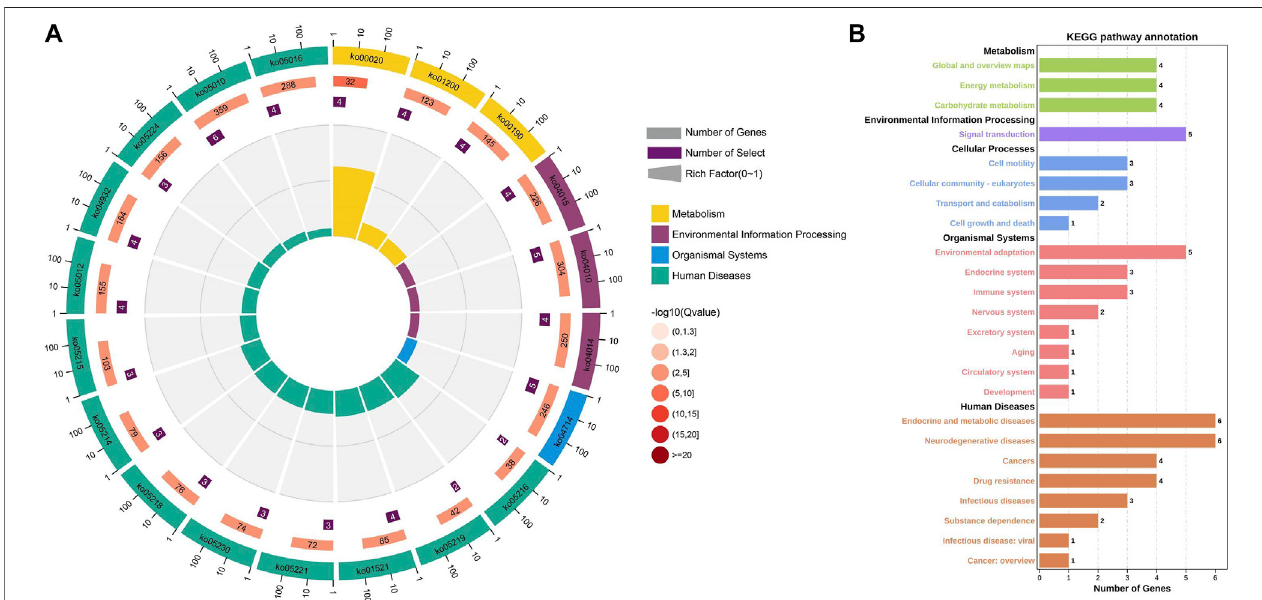
FIGURE 6 | KEGG pathway enrichment analysis of nine genes related to GIST (A) Circle Diagram of KEGG pathway enrichment analysis (B) Statistics of the enrichment number of the KEGG pathway.